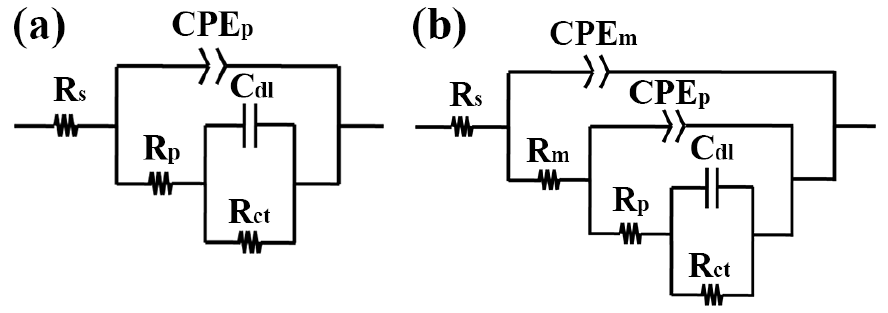
Figure 9. Equivalent circuits model for fitting EIS data of samples: ( a ) CG and SFT sample; ( b ) CG ‐ MAO and FG ‐ MAO coating.